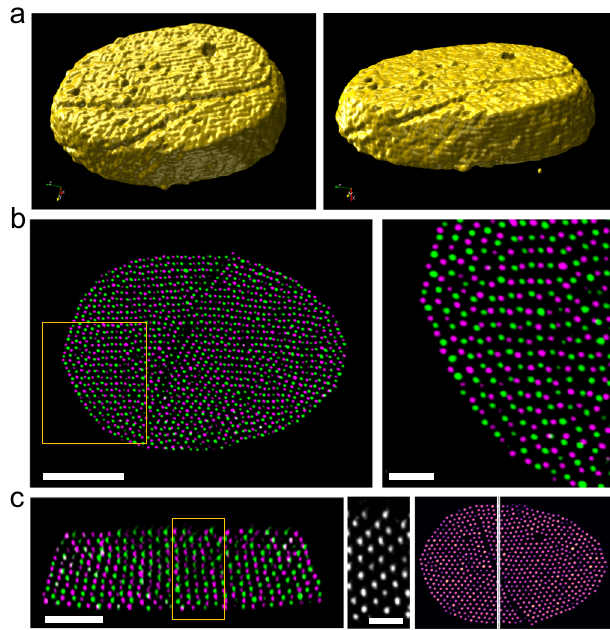
Fig. 3 Electron tomography and reconstruction of a single bcc crystal composed of (5.3k) Au-PS 0. 60 NPs on the substrate. PP/PE was added at + (cid:2) 0 : 1 % : a 3D visualization of the crystal surface (see “ Methods ” ) PP = PE clearly illustrating its overall shape and the defective top layers. b Two base plane layers plotted in green and purple, demonstrating a distorted hexagonal lattice in each plane. The registration between the layers is predominantly bridge sites, as seen in the enlarged view on the right. Scale bars are 100 and 25 nm. c Two consecutive planes within a vertical slice plotted in green and purple. PGNPs in one plane sit at the center of the PGNP squares in the other plane. The square lattice of one of the bcc (001) planes is shown in the enlarged view in the middle. The image on the right shows where the cut lies in the top view. Scale bars are 50 and 25